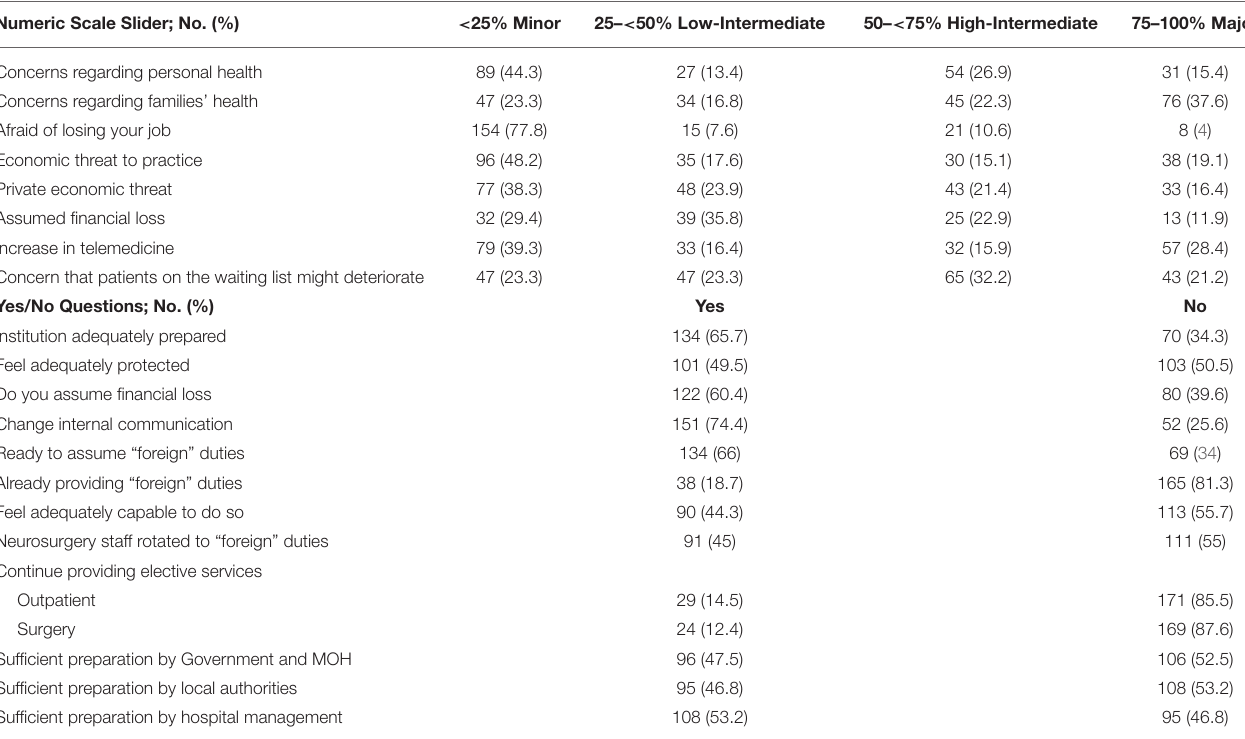
TABLE 1 | Individual perception of the crisis and crisis management.